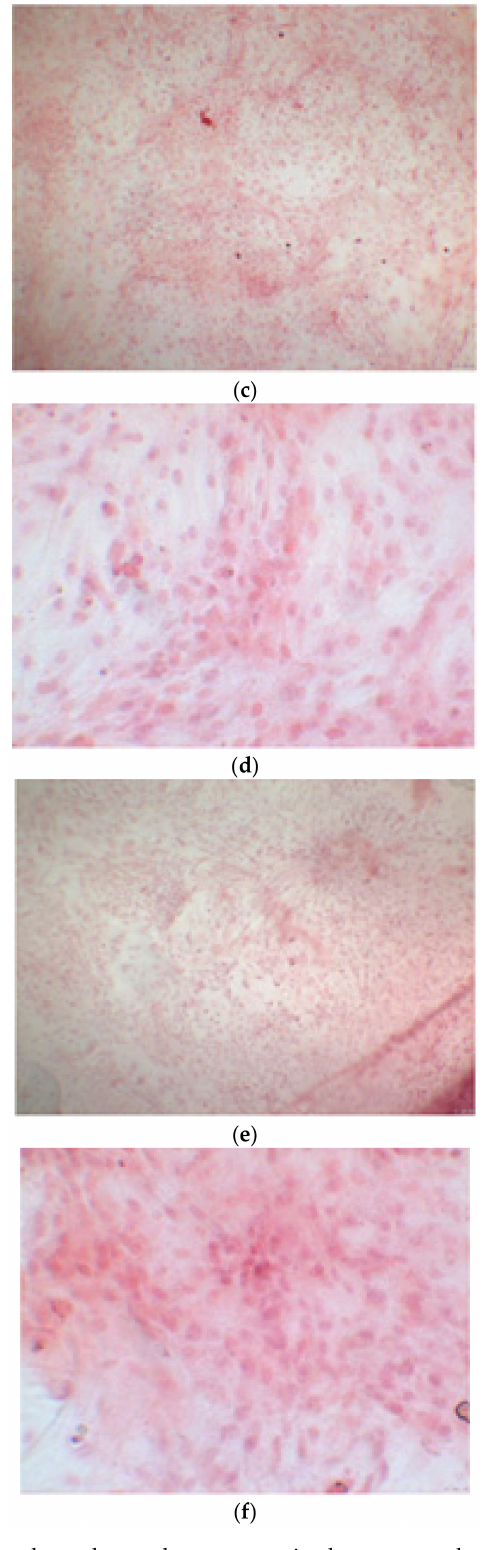
Figure 9. Clone 8 at 28 days showed a much more organized structure, where apparently there seemed to be less staining; this was only due to the fact that the cells, compared to the first test, had a delimited and organized structure ( a–f